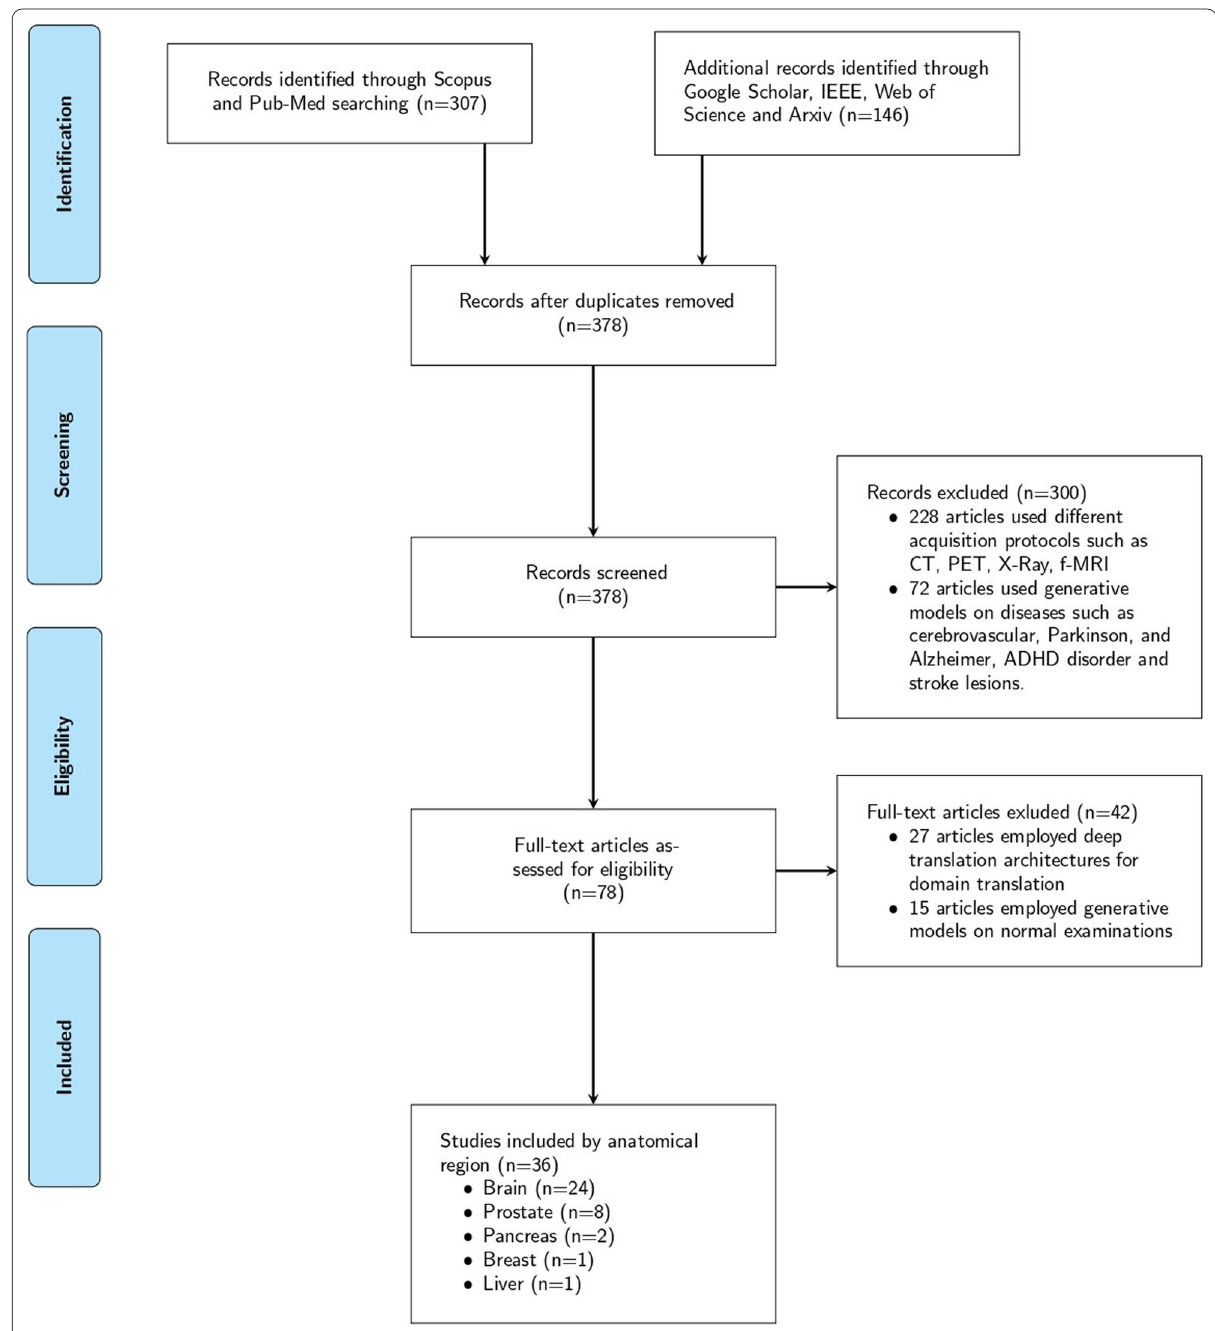
Fig. 2 The PRISMA flow diagram for the followed search